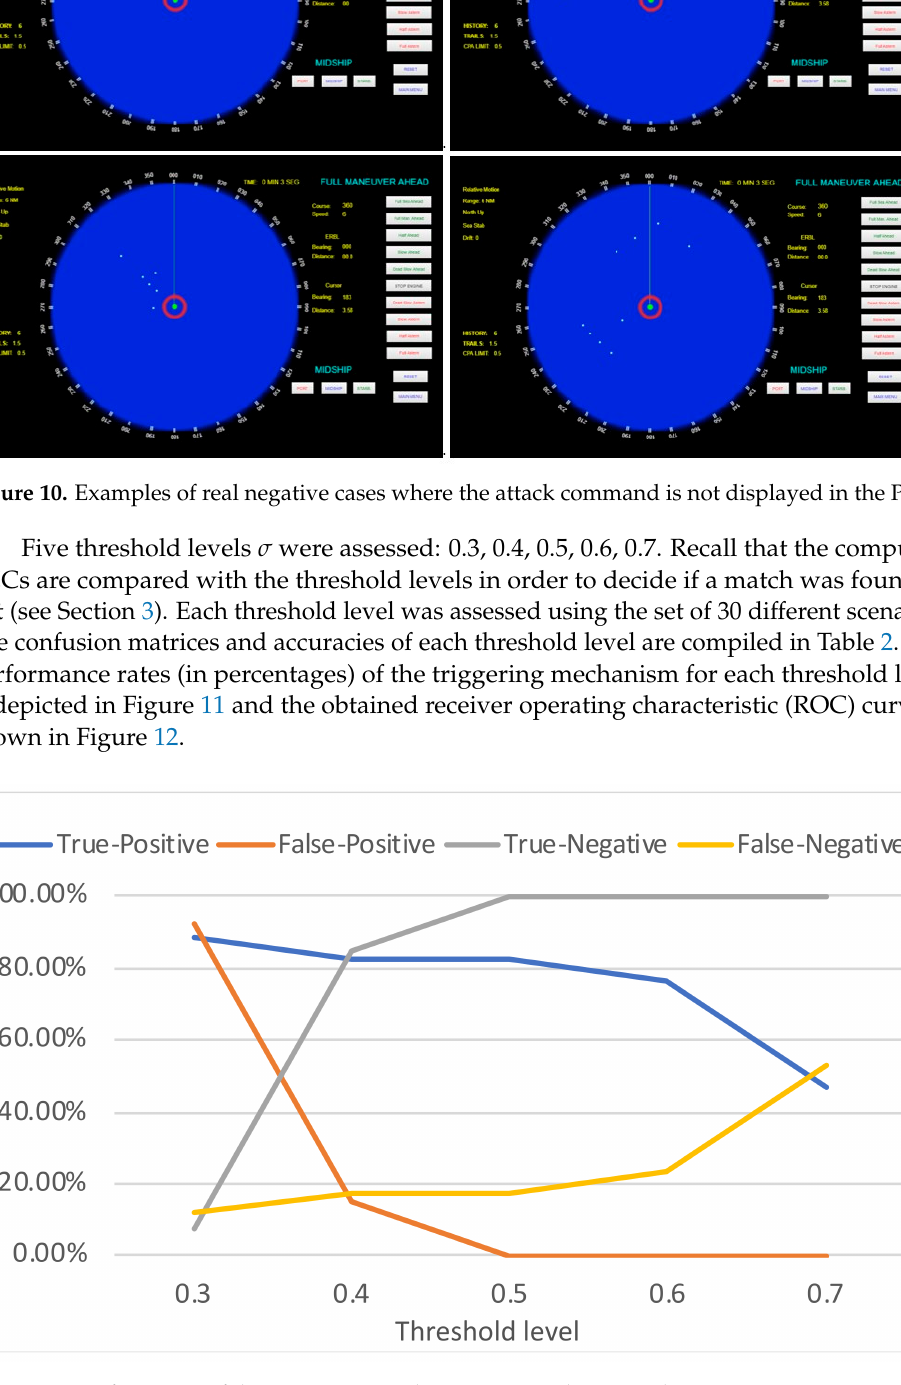
Figure 11. Performance of the triggering mechanism in attacks to a radar